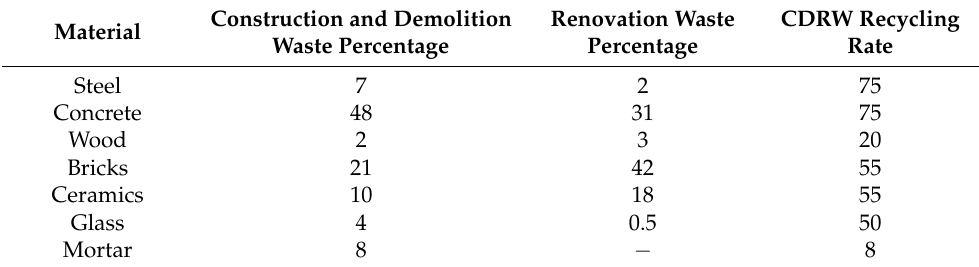
Table 3. Percentage and recycling rate of seven construction materials (unit: %).